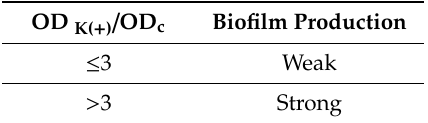
Table 1. Cut-o ff point for di ff erentiation of weak and strong biofilm